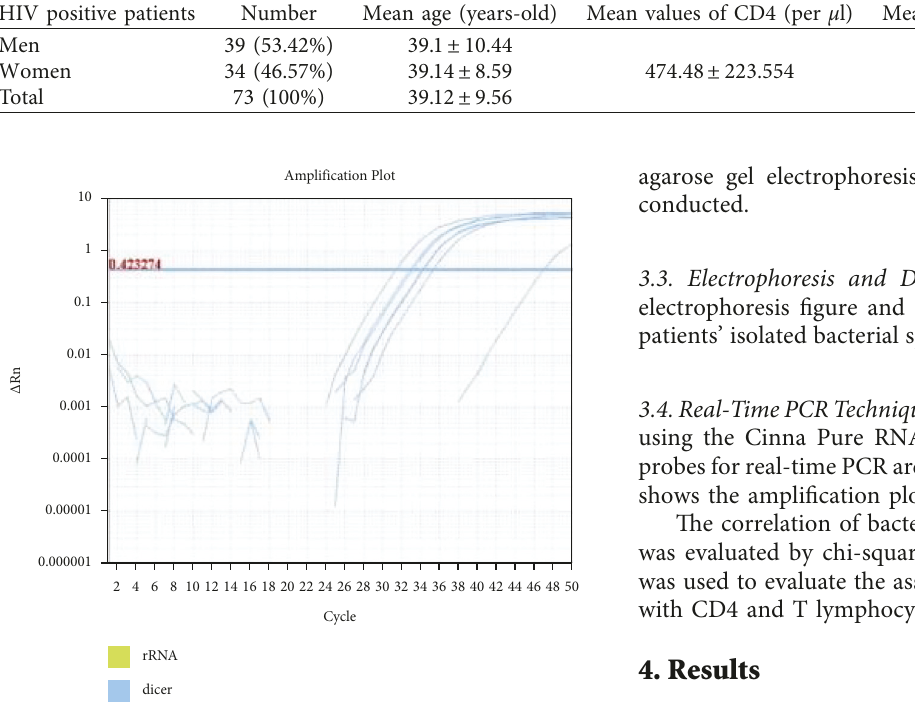
Figure 2: Amplification plot of real time PCR